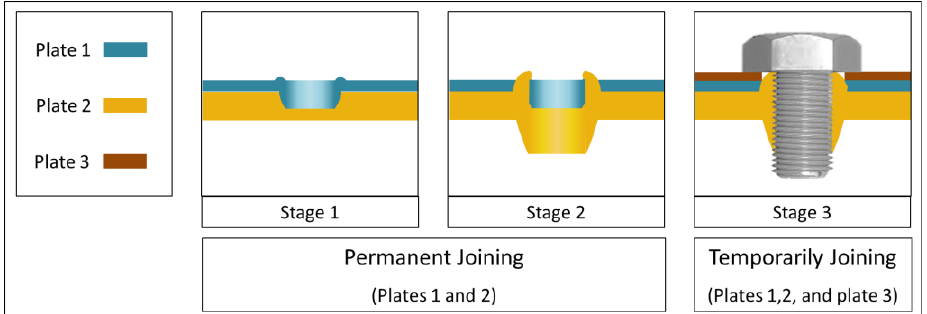
Figure 1. Schematic of the friction drill joining potential for thin sheets joining.